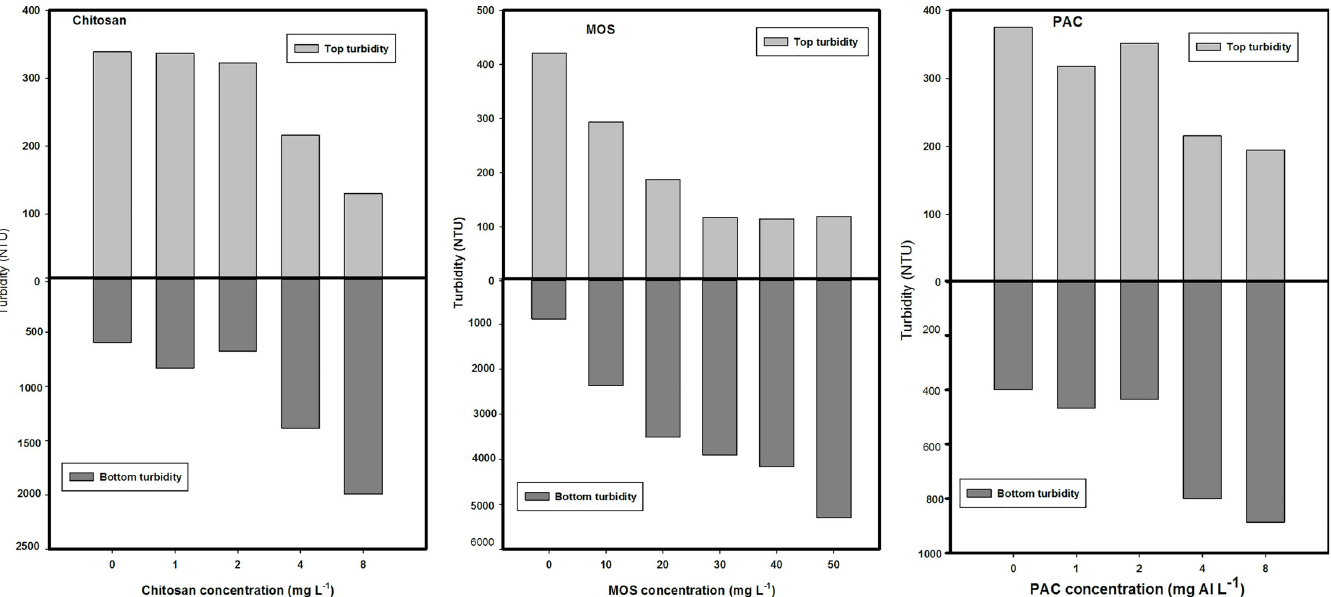
Fig 3. Effect of different flocculants on reservoir turbidity. Level of turbidity (NTU) in the top 2 mL and bottom 2 mL of cyanobacterial suspensions incubated for 1 h with different concentrations of flocculants: A) chitosan top light gray chitosan bottom dark gray B. MOS top light gray and MOS bottom dark gray C) PAC top light gray and PAC bottom dark